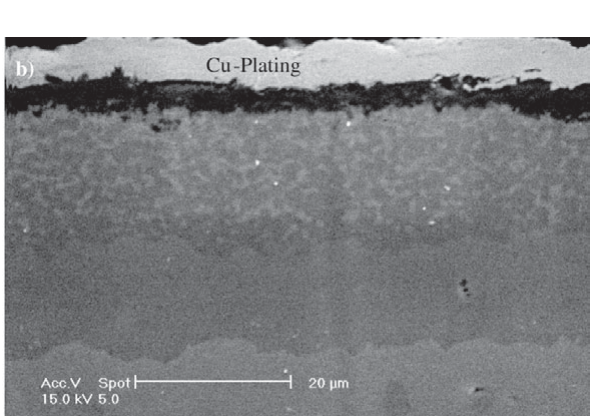
Figure 9 . Cross-section morphology showing oxide layers on Ti- Al intermetallics: a) uncoated, thick layer mainly composed of rutile; b) coated, thin and dense alpha-alumina layer (900